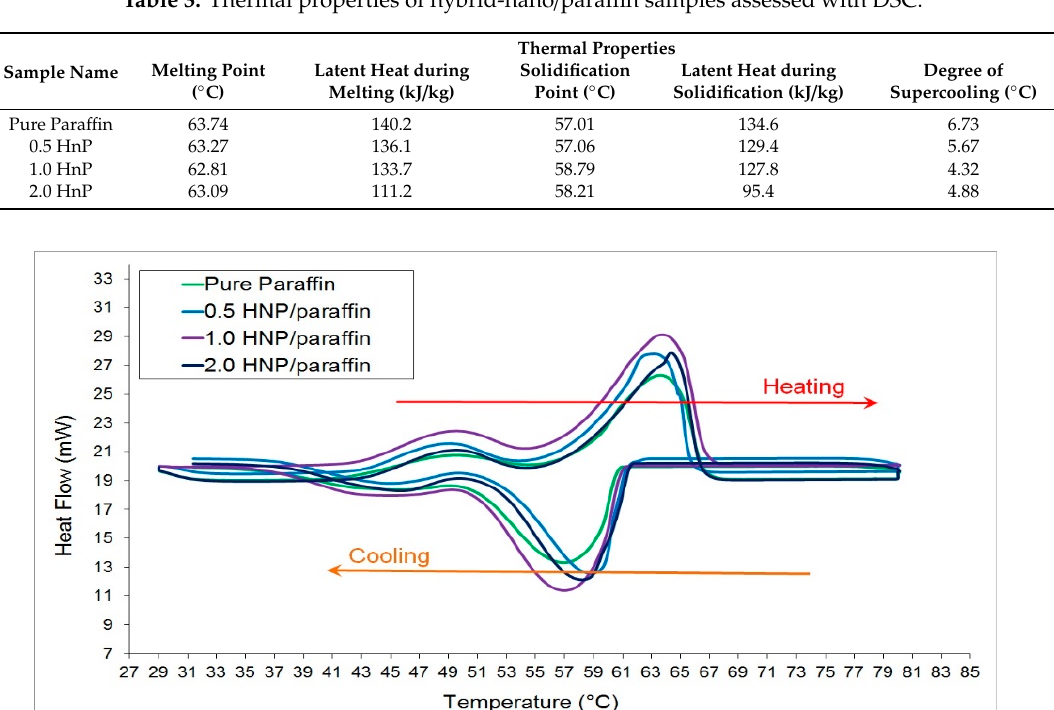
Table 3. Thermal properties of hybrid-nano / para ffi n samples assessed with DSC.